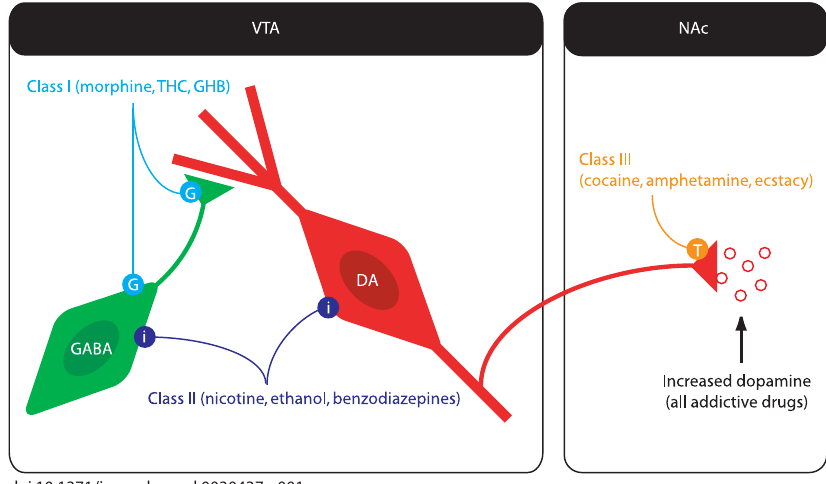
Figure 1. The Dominant Targets Involved in Increasing Dopamine for the Major Types of Addictive Drugs G, G -coupled receptors; i, ionotropic receptors/ion channels; T, monoamine i/o